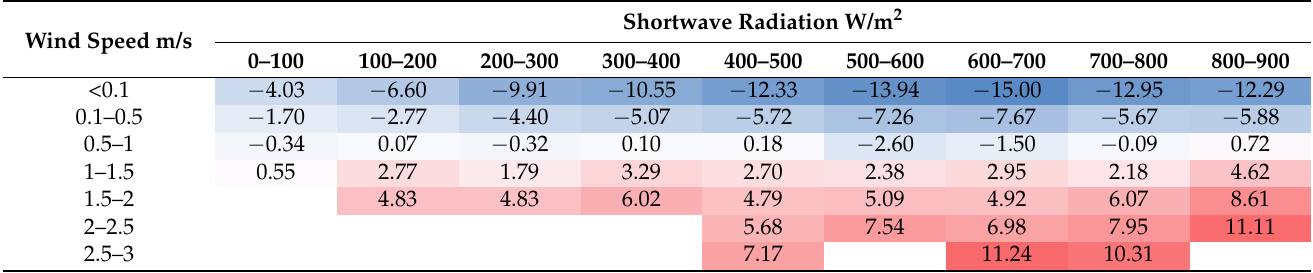
Table 6. Statistics of dTmrt results of various wind speed values in various temperature ranges (air temperature above 34 ◦